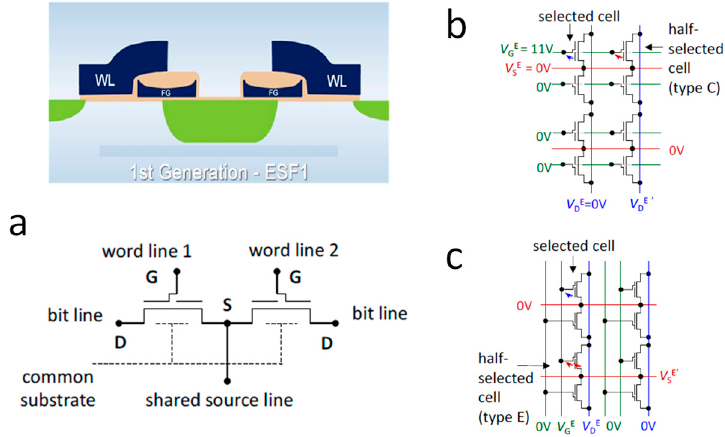
Figure 7. ( a ) Schematic cross-section of the Silicon Storage Technology (SST) cell structure ( top ) and its equivalent circuit ( bottom ) and NOR array with ( b ) classic and ( c ) modified routing together with the respective erase protocol. Reprinted with permission from [53]. Copyright 2015, IEEE.